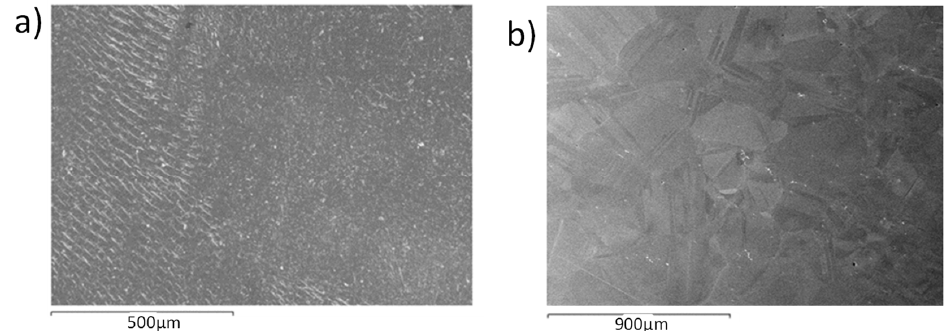
Figure 10. Microstructure and surface defects of CADCAM milled samples: ( a ) machining marks and ( b ) equiaxial grains with twins inside.